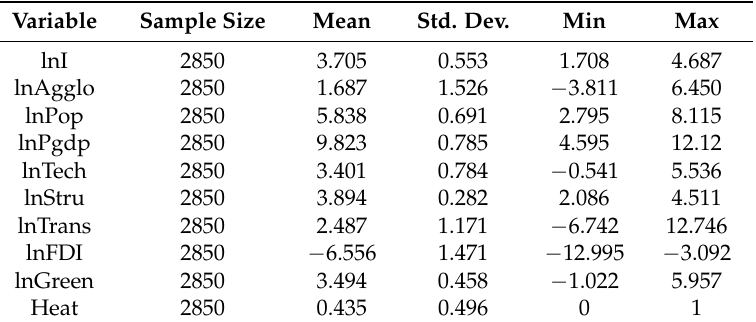
Table 1. Descriptive statistics of major